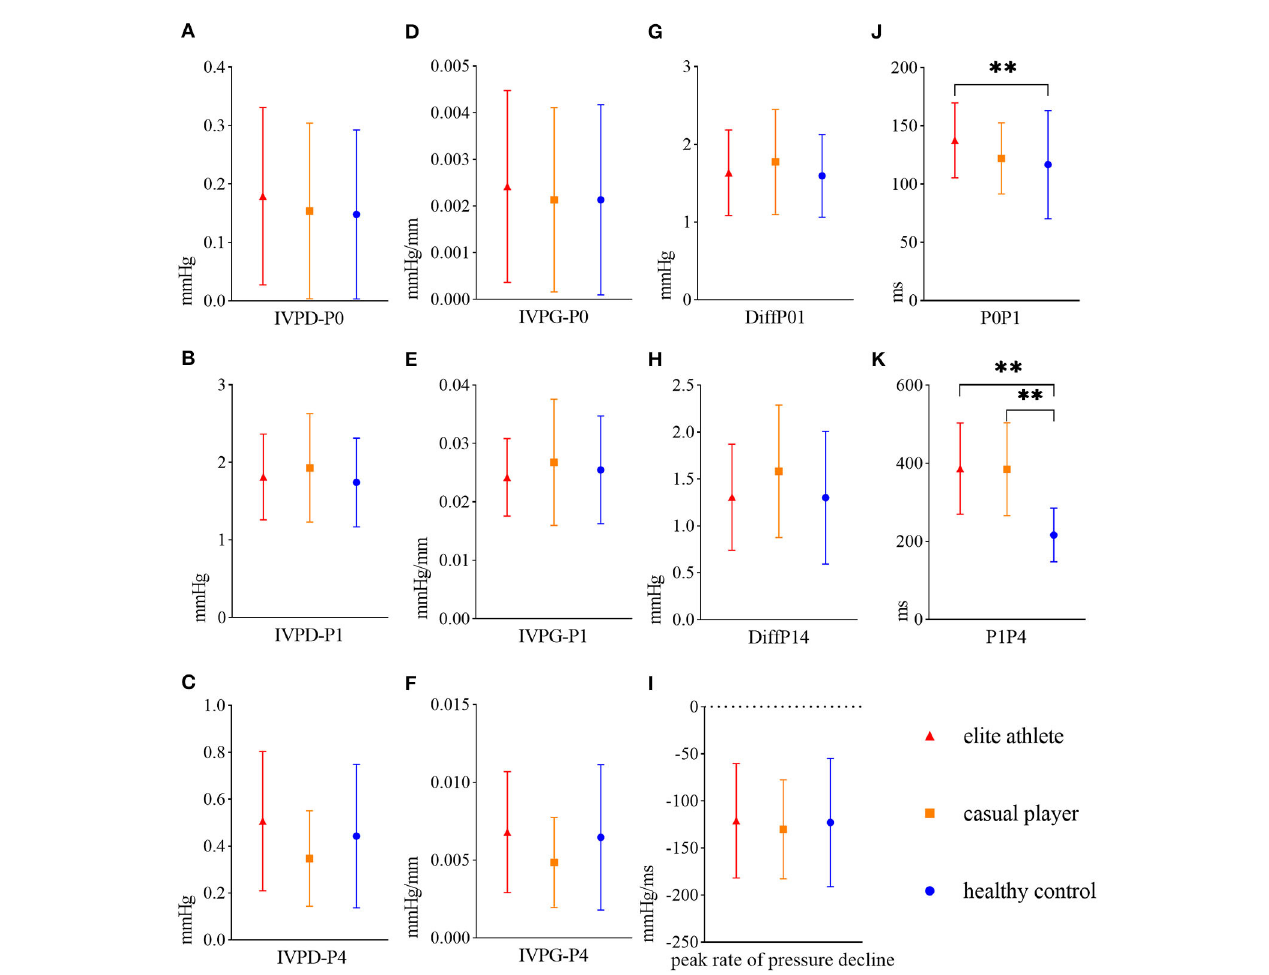
FIGURE2 Mean and standard deviations of LV diastolic hemodynamic parameters in elite athletes (red triangles), casual players (orange squares), and healthy controls (blue circles). (A) Peak IVPD of P0 (IVPD-P0), (B) peak IVPD of P1 (IVPD-P1), (C) peak IVPD of P4 (IVPD-P4), (D) peak IVPG of P0 (IVPG-P0), (E) peak IVPG of P1 (IVPG-P1), (F) peak IVPG of P4 (IVPG-P4), (G) difference in the peak IVPD between P0 and P1 (DiffP01), (H) difference in the peak IVPD between P1 and P4 (DiffP14), (I) peak rate of pressure decline, (J) time interval between P0 and P1 (P0P1), (K) time interval between P1 and P4